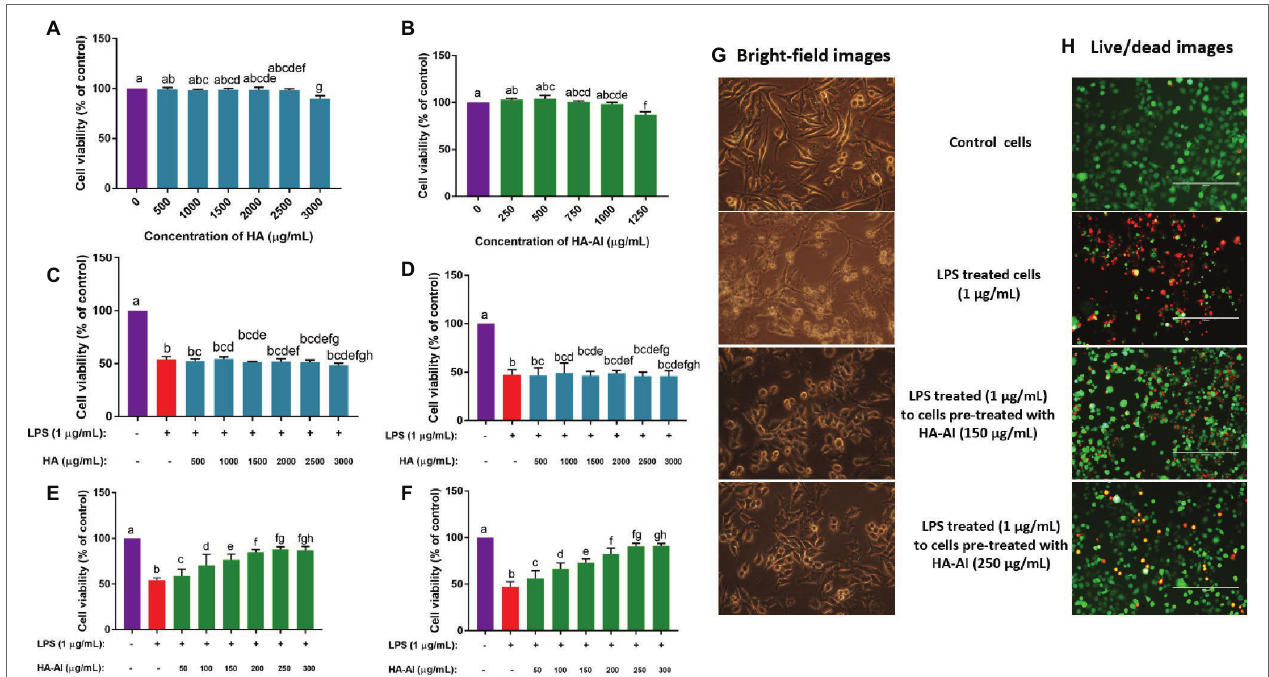
FIGURE 7 | Assessment of protective efficacy of hydroxyapatite (HA) and hydroxyapatite– A. indica (HA-AI) composite on LPS-induced death of RAW 264.7 cells by cell viability assays. Biocompatibility of (A) HA and (B) HA-AI composite on cell viability determined by MTT assay. Protective efficacy of HA against LPS-induced cell death determined by (C) MTT and (D) live/dead dual staining assays. Protective efficacy of HA-AI composite against LPS-induced cell death determined by (E) MTT and (F) live/dead dual staining assays. (G) Bright-fielding microscopic images representing the protective efficacy of HA-AI composite on LPS-induced cell death. The images were taken at magnification of 400×. (H) Live/dead dual staining microscopic images representing the protective efficacy of HA-AI composite on LPS-induced cell death. The scale bar is 200 μm. Green and red colors represent the live and dead cells, respectively. The experiments were performed individually in six replicates and achieved results were stated as mean ± standard deviation. The data were statistically evaluated by one-way ANOVA following Tukey’s post hoc multiple comparison test. The statistical variance among the experimental groups was measured as significant at p < 0.05. The columns with different alphabets were significant within the respective